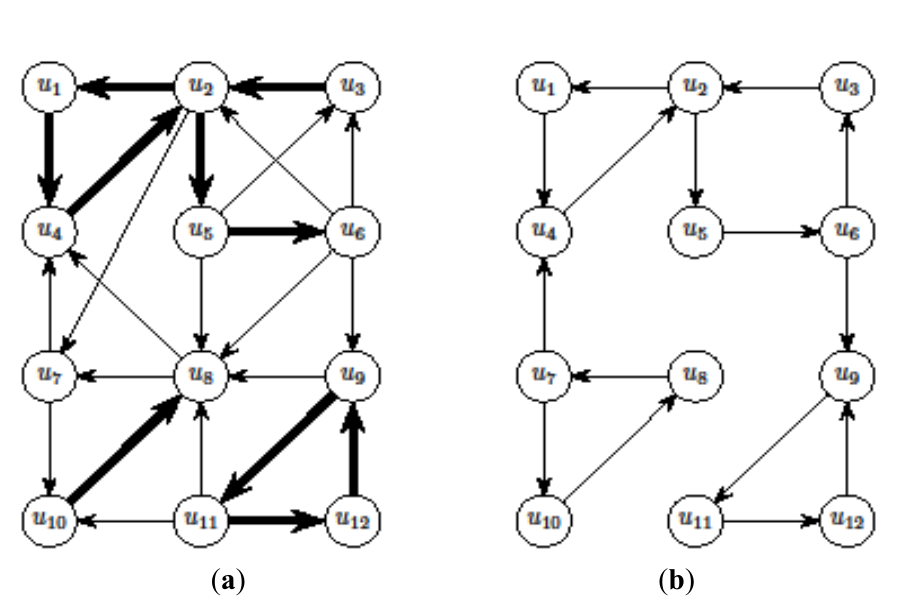
Figure 4. An illustration of the initial solution A discussed in the algorithm that applies a 1 L P -based approach to critical-M IN -E D in Section 3.5.1: ( a ) The input graph G; ( b ) The edges in the initial solution A . As one can see, the initial solution does not provide a valid 1 solution of critical-MIN-E D since the graph in Figure 4b is not strongly connected, but the final solution is obtained by adding and deleting edges from this initial